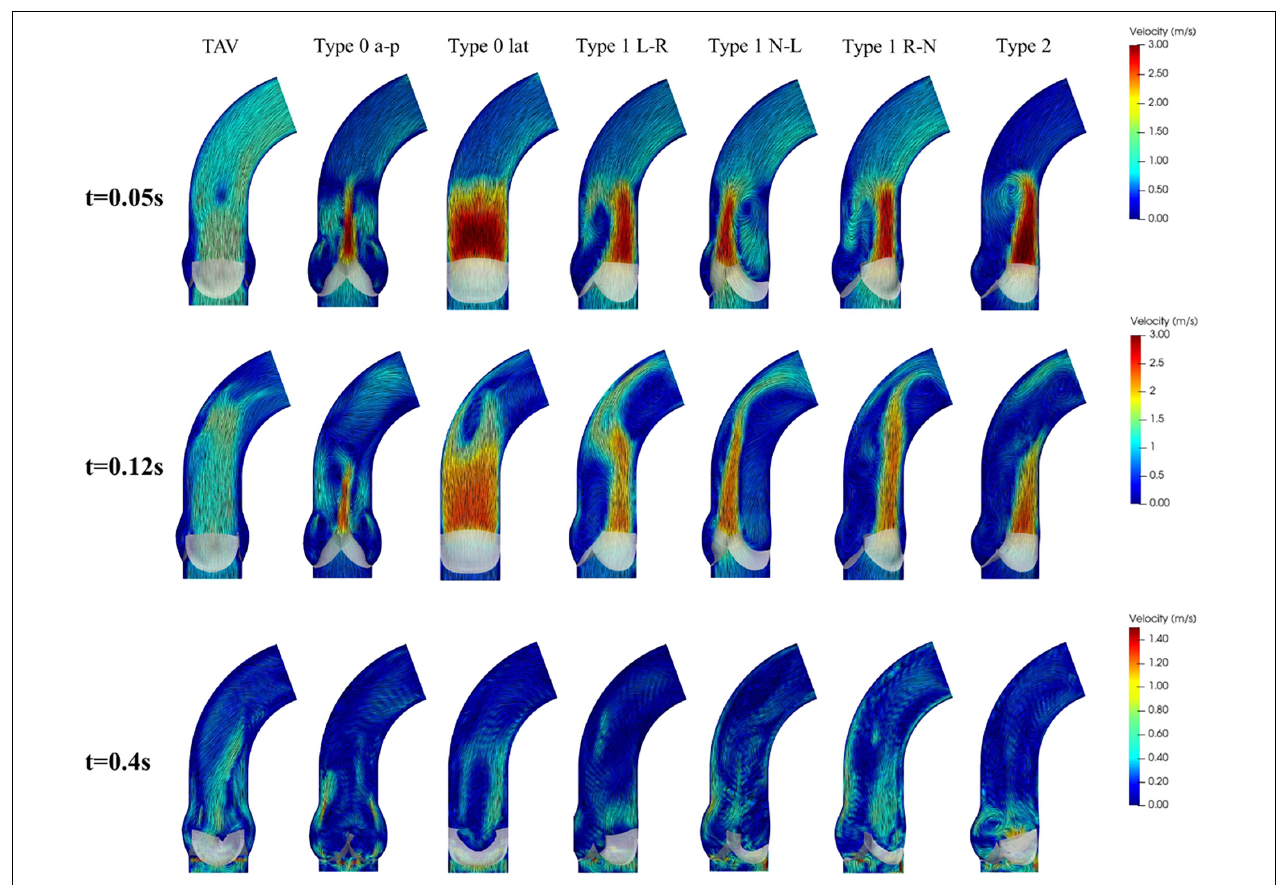
FIGURE 7 | Flow patterns and streamlines of TAV and BAV at some characteristic moments ( t = 0.05, 0.12, 0.4